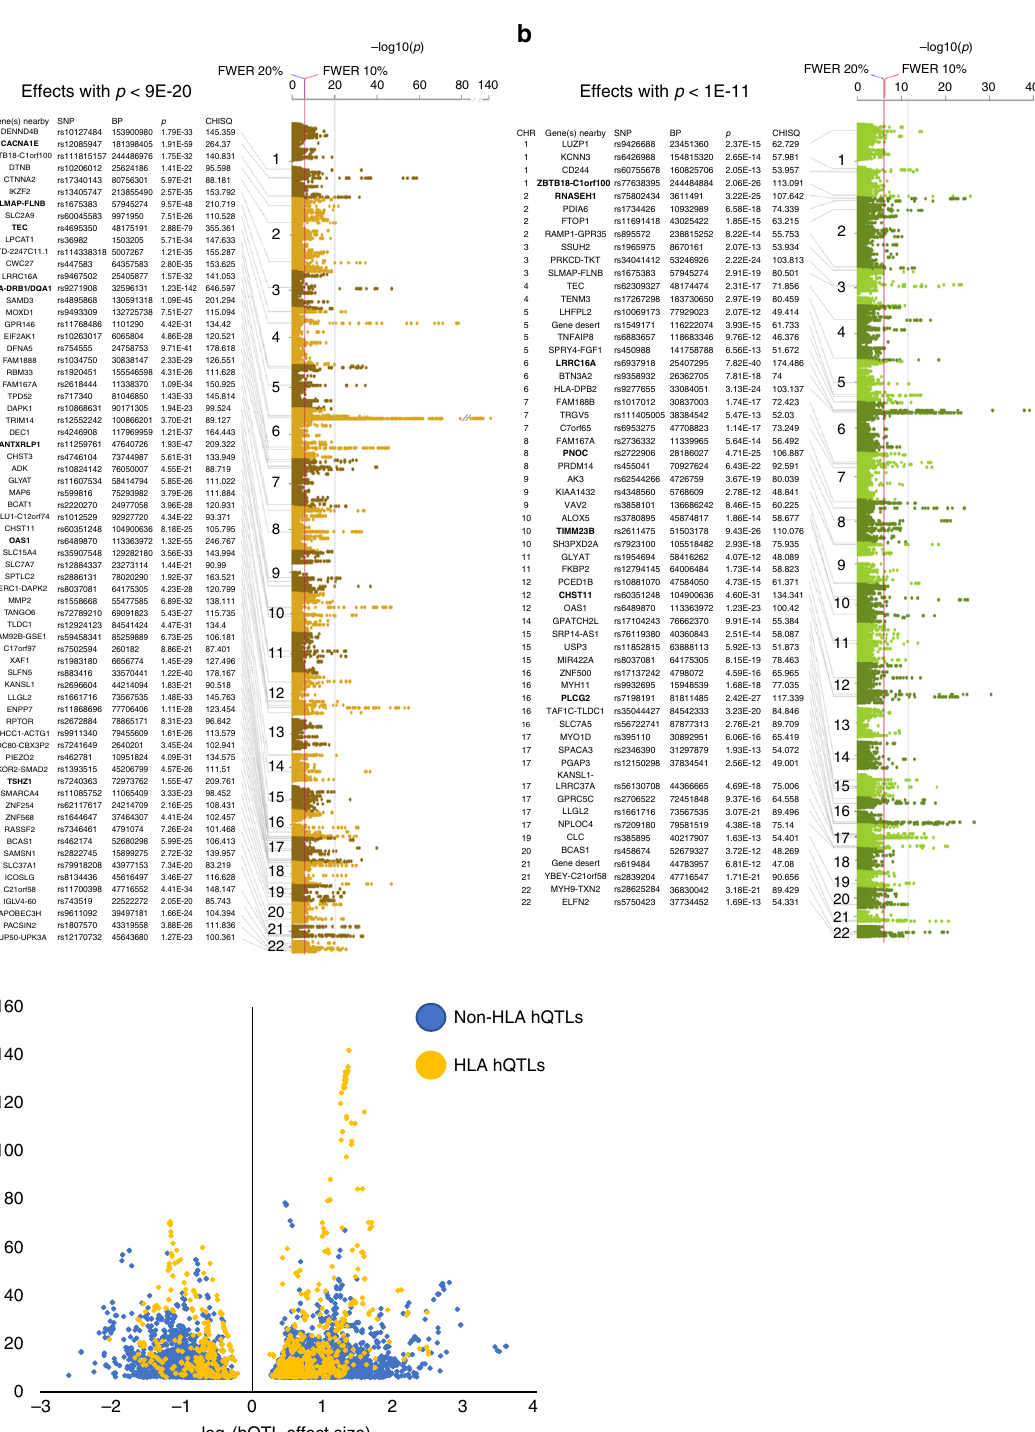
Fig. 1 hQTL Manhattan plots and plot of hQTL effect sizes. Top effects for a the H3K27ac mark ( p < 1E − 30, vertical gray line), and b the H3K4me1 mark ( p , < 1E − 15, vertical gray line) are indicated. Strongest effects for each mark are in bold. Red vertical line indicates the 10% FWER threshold (nominal p , = , 8.9E − 07); blue vertical line indicates the 20% FWER threshold (nominal p = 9.8E − 07). Y -axis is the − log is plotted on the x -axis. c Volcano plot of the hQTL effect sizes. The log 2 (effect size) is plotted on the x -axis where values >0 had more reference than alternate allele speci fi c reads and those with effect size values <0 had more alternate than reference allele speci fi c reads. Y -axis is the − log 10 ( p ) from the CHT. hQTLs located in the HLA region are in yellow and non-HLA hQTLs are in